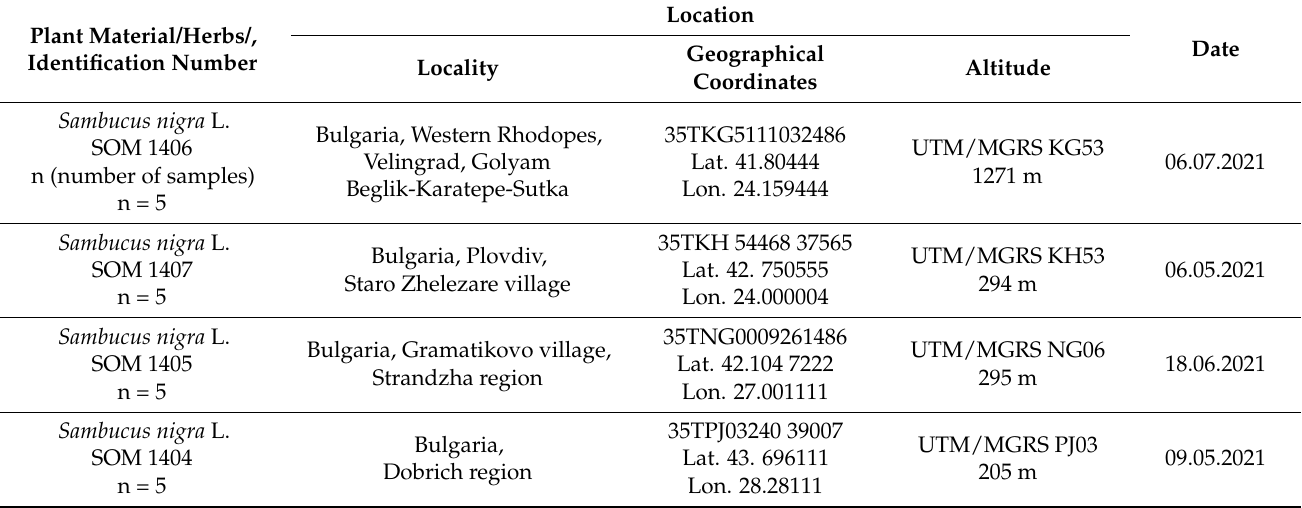
Table 2. Necessary data for the identification of the studied plant species.